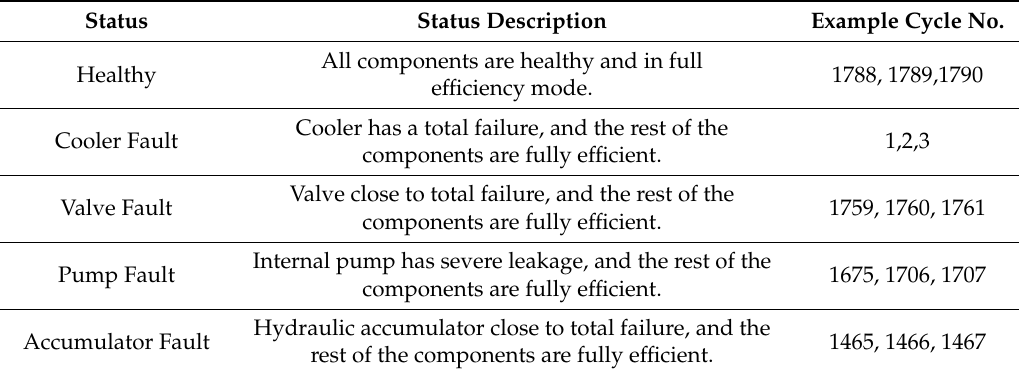
Table 2. Hydraulic Test Rig Chosen Faults and Their Full Description.